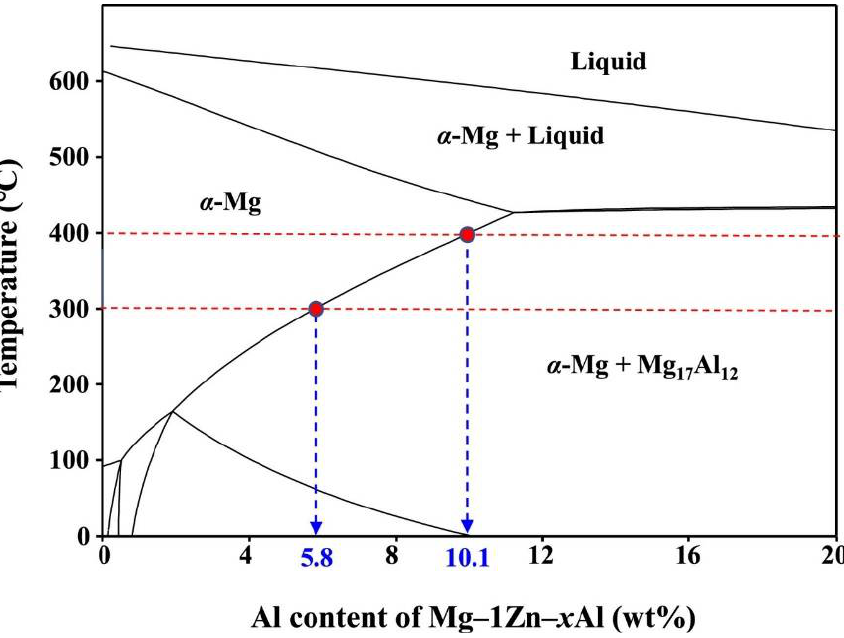
Figure 1. Phase diagram of Mg–1Zn–xAl (PANDAT Software) [19]. Graphite powder was used as a high-temperature lubricant, which tends to prevent sticking of working material at high temperatures, to achieve reasonable homogenous deformation. Before forging, a resistive furnace was used to heat the homogenised samples and two anvils to 360 ◦ C for half an hour. During forging, the samples were not annealed. After the final pass, these forgings were cooled in water. The AZ80 was made stronger through age hardening at 175 ◦ C and subsequent forging [21]. High pressure die casting (HPDC) has recently been applied to the production of Mg alloy systems of Mg, Al, Zn, and Mn in an effort to achieve superior mechanical properties without compromising the cost of processing. Because the mechanical properties of various processed materials are listed in Table 1, it is easy to see how the physical phenomenon or processing parameters of the alloy affects the microstructure and the phases in the alloy [22]. The depositing process is called wire additive manufacturing, and it employs extruded AZ80M alloy with a diameter of 1.6 mm. There is micro-cracking in the inter-transition layer and inhomogeneity in the grain structure in AZ80M that was produced using additive manufacturing. The horizontal di- rection also has greater tensile strength than the vertical [23]. Different properties along the horizontal and vertical directions, as well as their significance depending on the product’s intended use, are present in additively made parts. Rolling and extrusion, two common bulk deformation processes, are frequently used in the processing of AZXX Mg alloys [24]. The refined grains were observed on the outer surface, but they became coarser towards the centre. On other hand, the casting process leads to uniform grain size throughout the specimen with the coarser grains. Refined grains, homogeneity, and hardness of AZXX Mg alloy cannot be achieved by a single processing technique. However, it is possible through the combination of processing techniques, along with a heat treatment process (solid solutionizing, and age hardening)